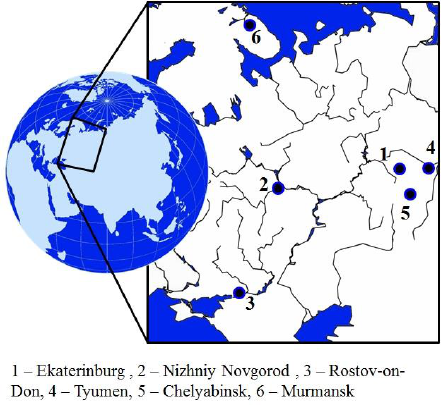
Figure 1. The locations of cities studied.